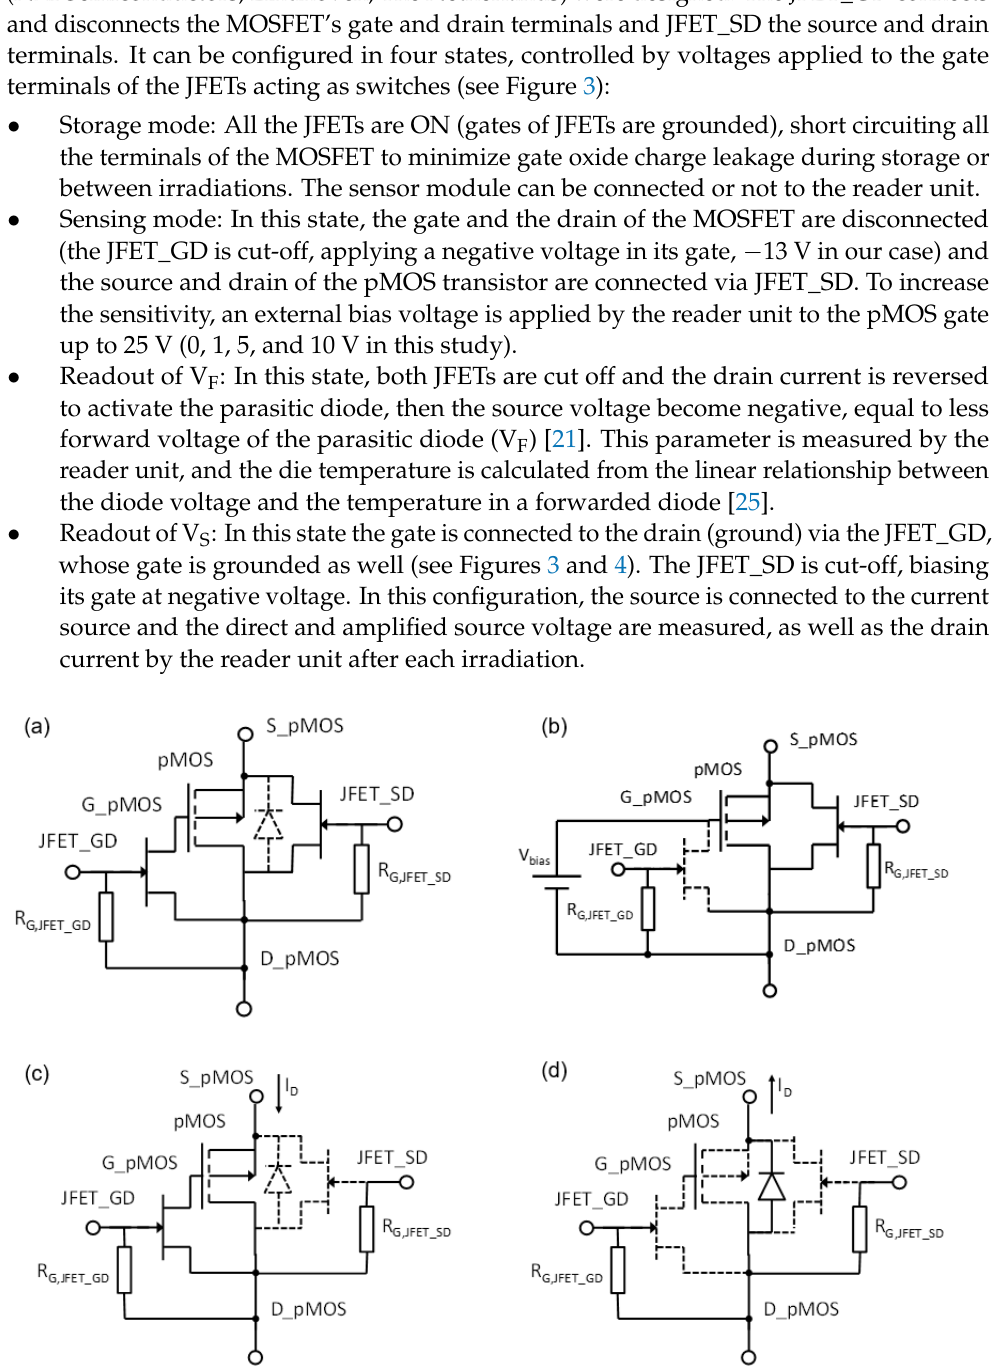
Figure 4. Measurement chronogram: In blue the source voltage is displayed; in green the gate volt- age of the MOSFET; in red the gate voltage of the JFET_GD and, in yellow, the gate voltage of the JFET_SD. The readout of V F or V S and sensing modes are selected during each irradiation and rest periods and the results are sent to the computer every 4.6 seconds, as Figure 4 shows. To avoid the body effect, the bulk terminal is connected with the source terminal in all states. To minimize the temperature effect, the reader was configured to measure, biasing the pMOS in the readout mode at I ZTC , the minimum temperature coefficient drain current (230 µA in our case [26]), at this current the temperature coefficient of the source voltage is minimum. In addition, the silicon temperature was monitored during measurements,